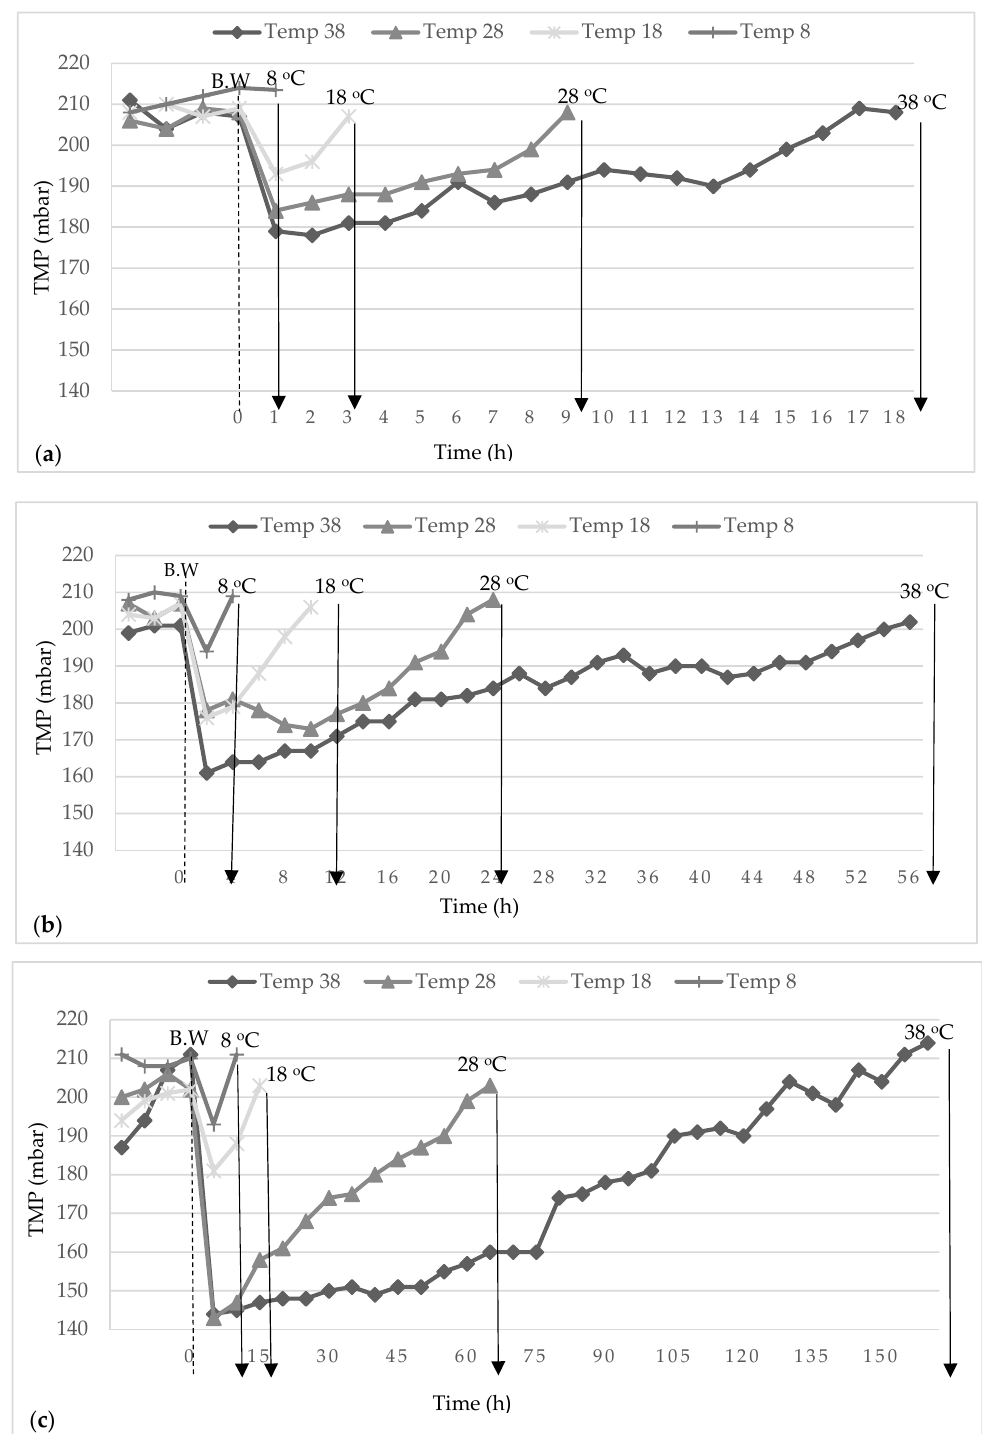
Figure 3. Mean TMP monitored values for the continuous operation of the MBR following BW at all examined water temperatures for BW duration of ( a ) 1 min, ( b ) 3 min and ( c ) 8